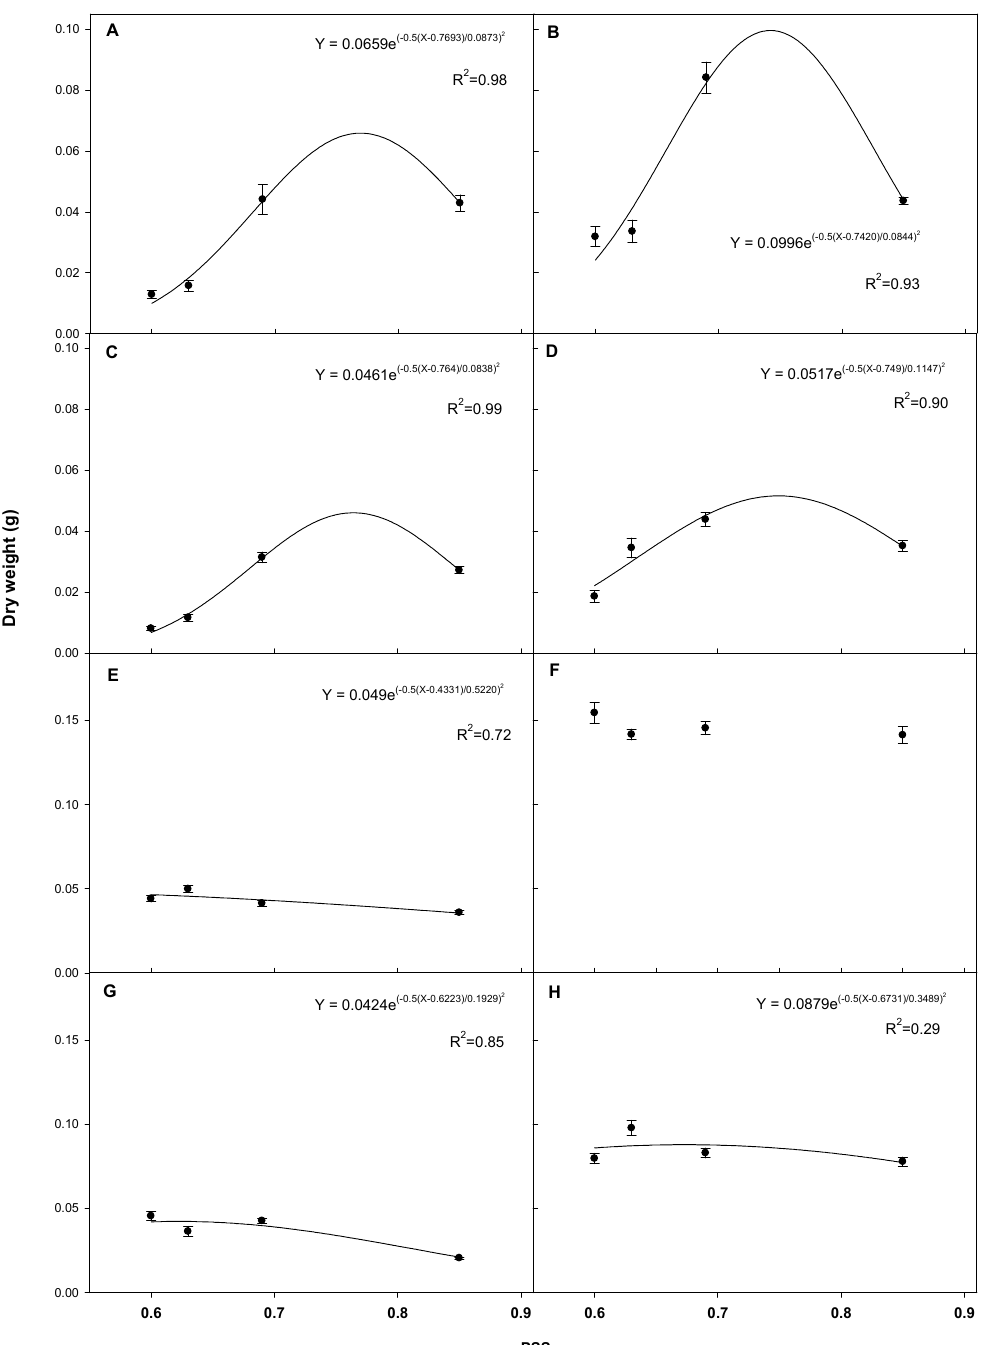
Figure 5. Regression of shoot dry weight versus phytochrome stationary state (PSS). The value of each point is the average dry weight of the “Dotaerangdia” ( A ) and “B-blocking” ( B ) tomato at 14 days after sowing (DAS), “Shinhong” ( C ) and “Tantan” ( D ) red pepper at 14 DAS, cucumber ( E ) and gourd ( F ) at 7 DAS and watermelon ( G ) and bottle gourd ( H ) at 9 DAS under the different supplemental far-red-enriched LED lighting treatments. Data represent the mean of three replications with eight plants per replication per species/cultivar. Vertical bars represent standard errors of means.